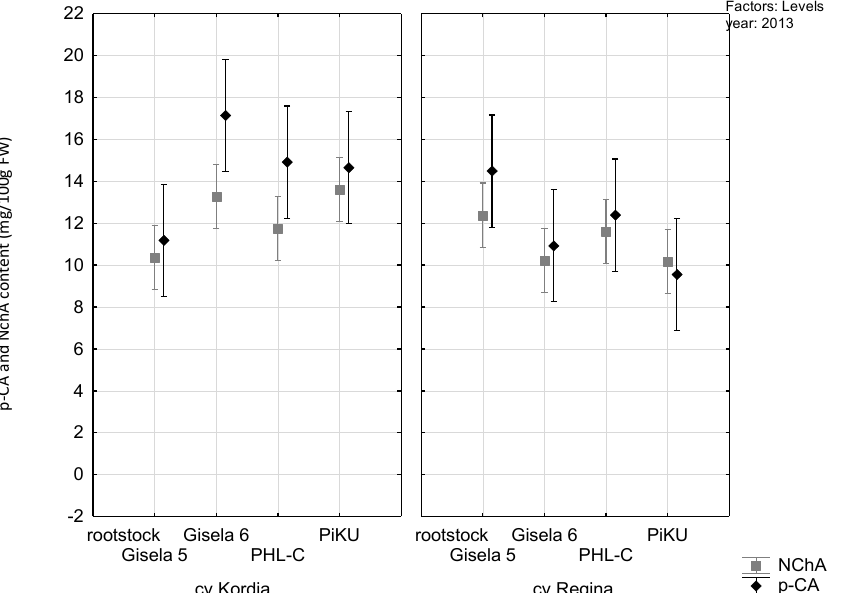
Fig. 2: p-Coumaric acid (p-CA) and neochlorogenic acid (NChA) (mg/100 g FW) of cvs. ‘Kordia’ and ‘Regina’ grafted on 4 different rootstocks during 2013